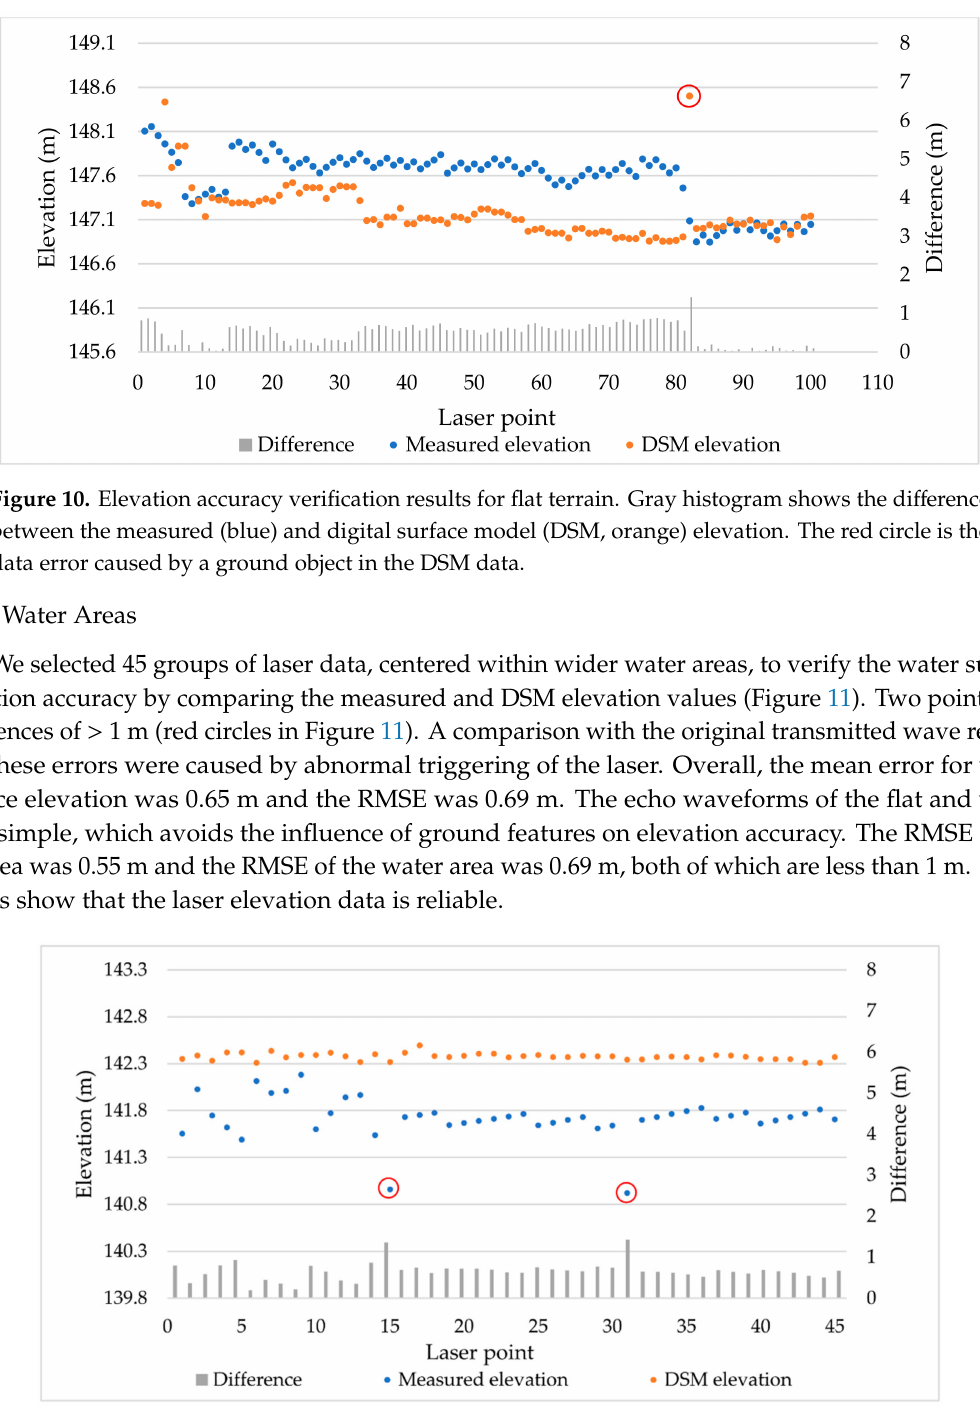
Figure 11. Elevation accuracy verification results in water areas. Gray histogram shows the di ff erence between the measured (blue) and DSM (orange) elevation values. Red circles are data errors caused by abnormal laser